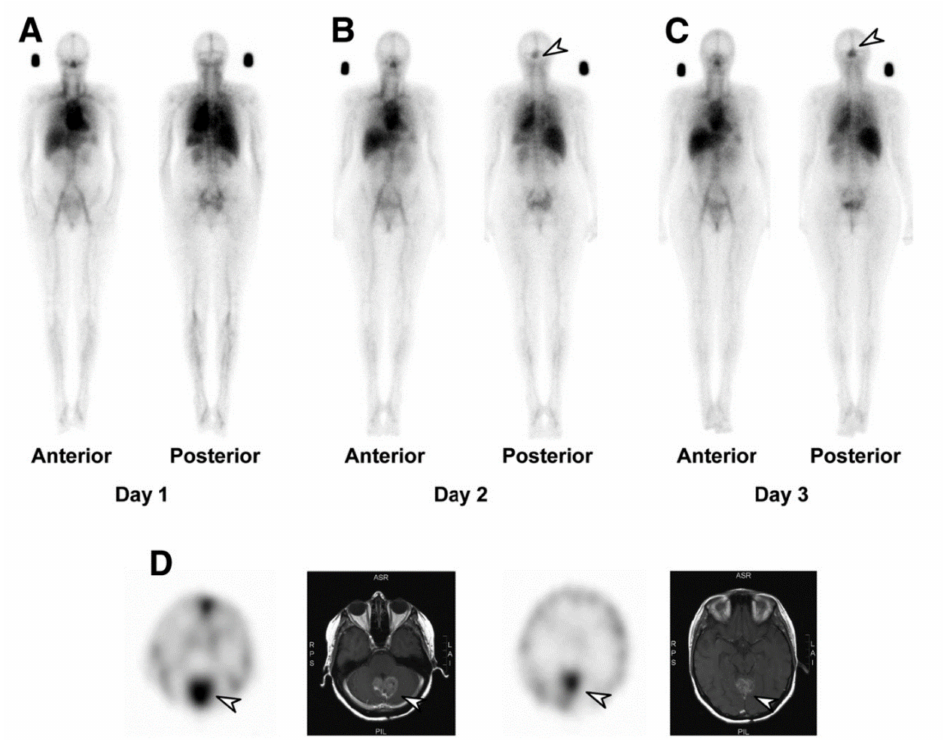
Figure 1. 111 In-ABT-806 (ABT-806i) biodistribution and SPECT/CT images of patient with high-grade glioma on ( A ) day 1, ( B ) day 2, and ( C ) day 3, demonstrating that rapid uptake of ABT-806i in known glioblastoma (arrow) is identified as early as day 2 and increases over time. ( D ) SPECT/MR images showing high uptake of ABT-806i in glioblastoma (arrow) in a posterior fossa lesion. Visualization of ABT-806i uptake in the anterior venous sinus is due to blood-pool activity. Reprinted with